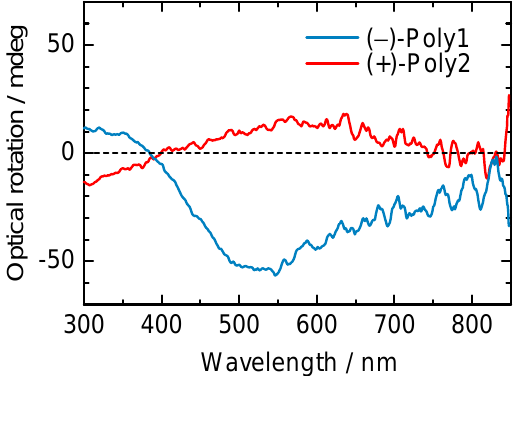
Figure 5. ORD spectra of (–)-poly1 and (+)-poly2 in cast films.